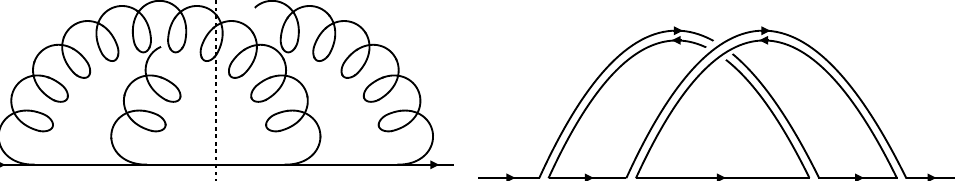
Figure 3: Graphical representation of correlated two-gluon emission in the collinear limit from a quark. Left: An example Feynman diagram for the squared amplitude, with the dashed vertical line representing the cut that exposes the final state particles. Right: The corresponding birdtrack diagram that tracks the flow of color amongst the